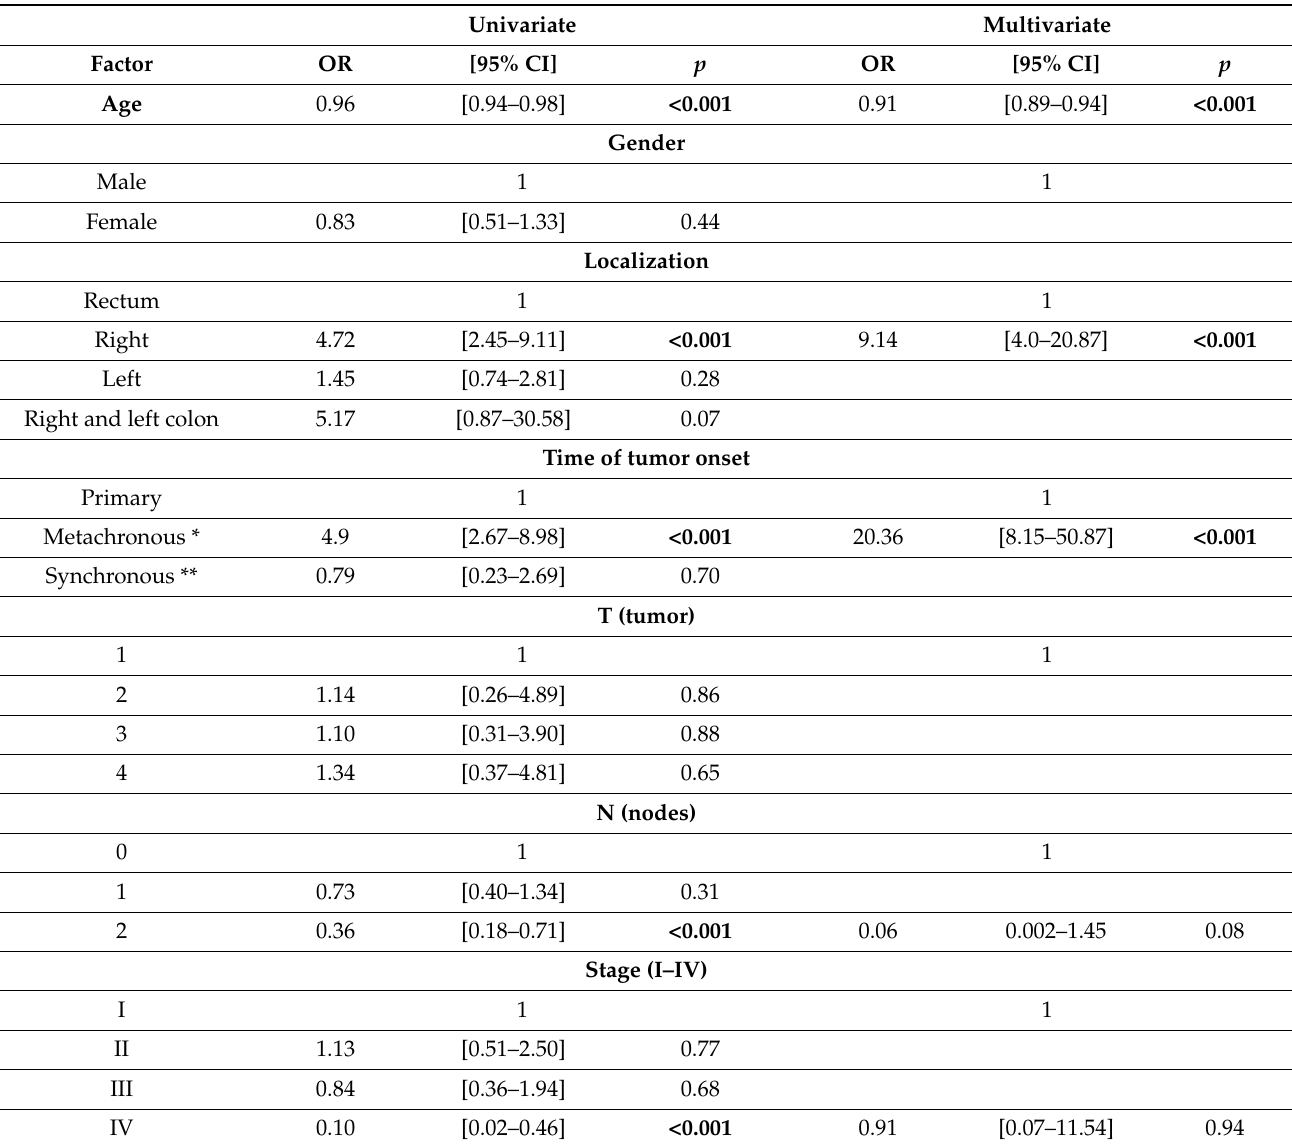
Table 3. Univariate and multivariate analysis of risk factors for patients with MSI. Univariate